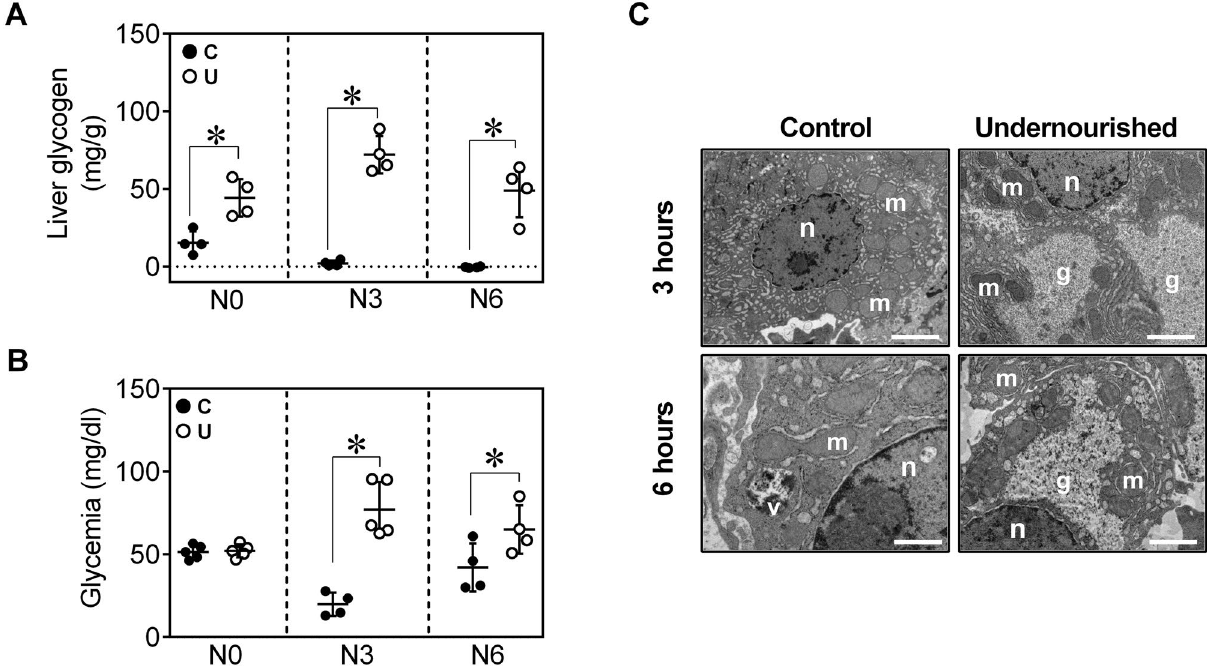
Figure 2. Increased hepatic glycogen storage but reduced glycogen mobilization in IUGR newborns. ( A ) Glycogen content in livers and glycemia ( B ) from C or U neonates at N0, N3 and N6, n = 4–5. ( C ) Representative electron microscopy images showing glycogen content in hepatocytes from C and U neonates at N3 and N6 (scale bar, 500 nm); n: nucleus, m: mitochondria, g: glycogen. All values are mean ± SD. * p < 0.05 U versus C neonates at the same time